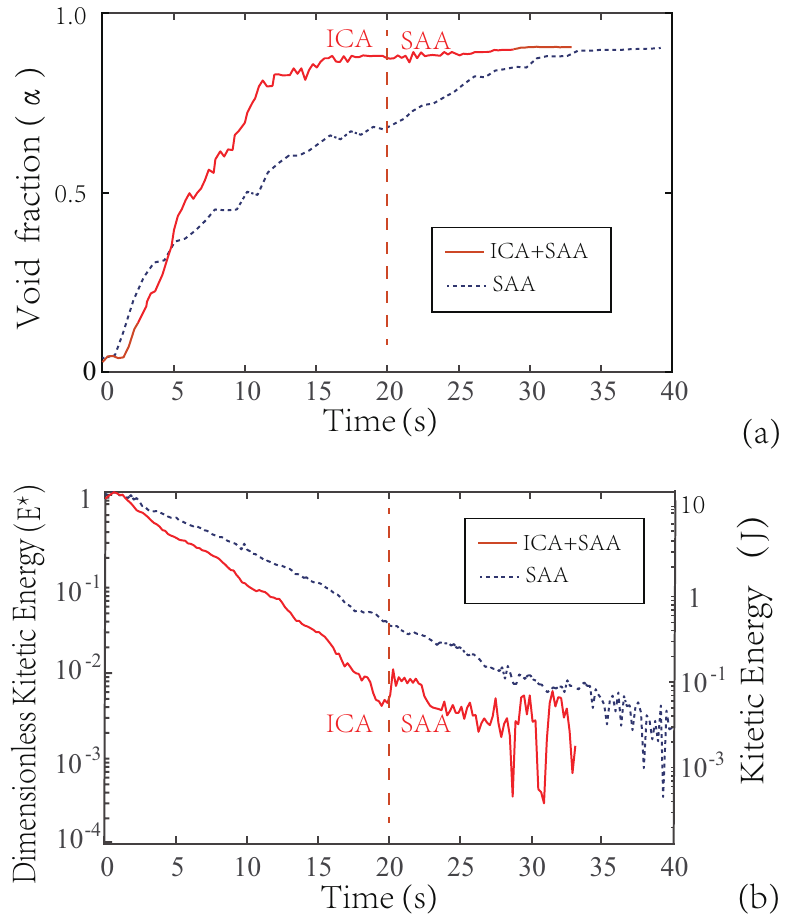
Figure 6. A comparison between simulations using the ICA and SAA algorithms. The simulation with the ICA involves two stages. It is simulated with imaginary coats and a low COR, e = 0.02, for all particles before t = 20 s in the first stage, and without imaginary coats and a normal COR, e = 0.2, after t = 20 s in the second stage. ( a ) Void fraction and ( b ) kinetic energy of the whole